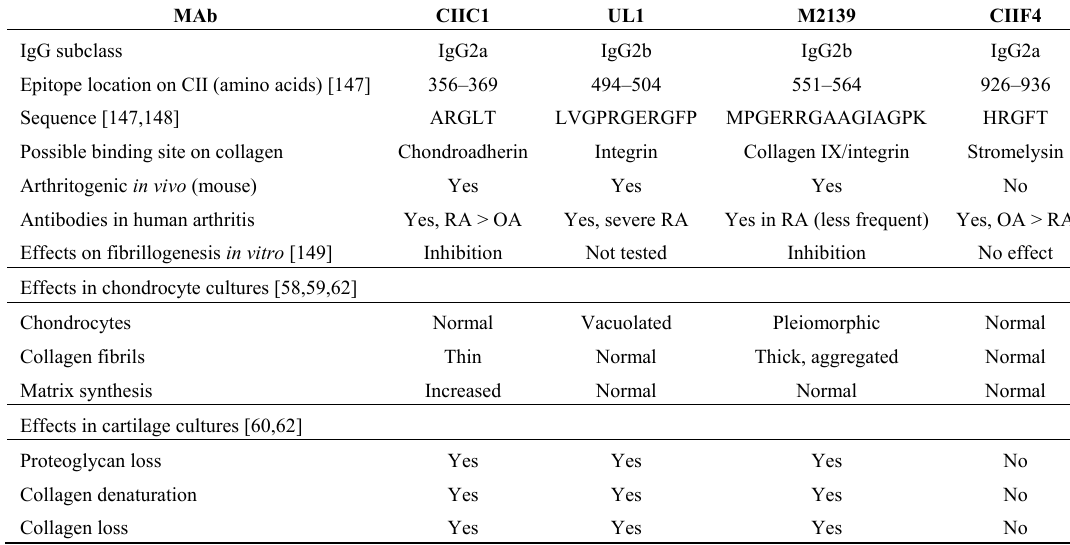
Table 3. Mouse mAbs to CII used for mapping and defining epitopes in collagen antibody induced arthritis (CAIA) 1